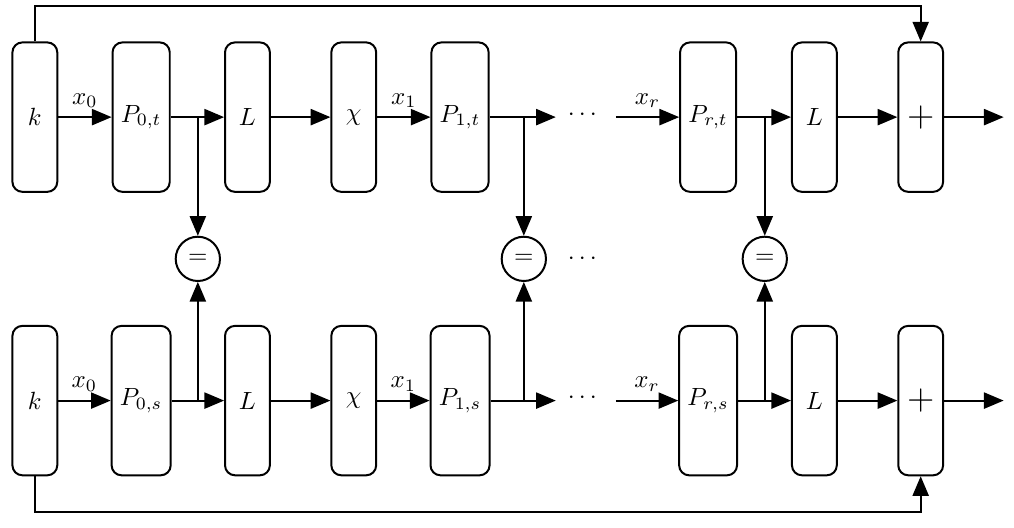
Figure 4: Similarity Attack on Dasta